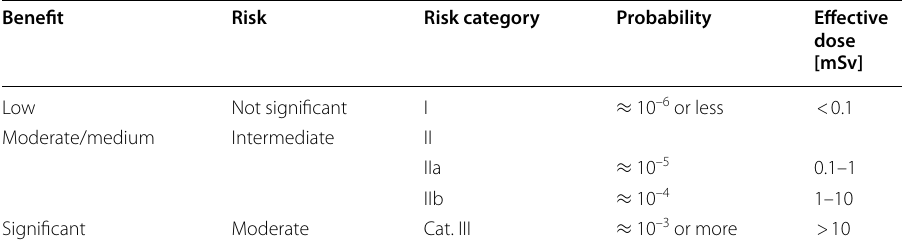
Table 4 Risk categories dependent on effective dose. Limits valid for population < 50 years, excluding